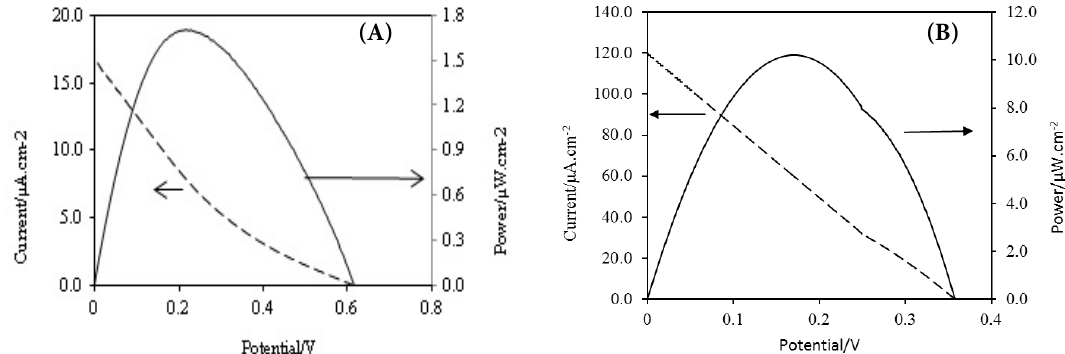
Fig. 5: Polarization curve (dotted line) and power curve (solid line) obtained by the ethanol/O /HOOC-MWCNT/GC or Cfelt bioanodes (A and B). The experiments were measured in oxygen saturated PBS (0.1 M, pH 7.5) containing 1 mM ethanol and 1 mM NAD +